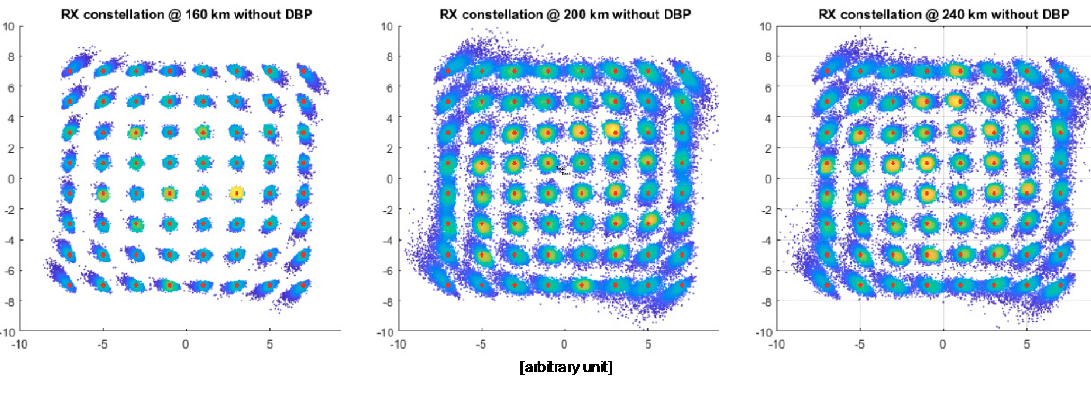
Figure 7. Constellation diagrams of simulated nonlinear distortion.